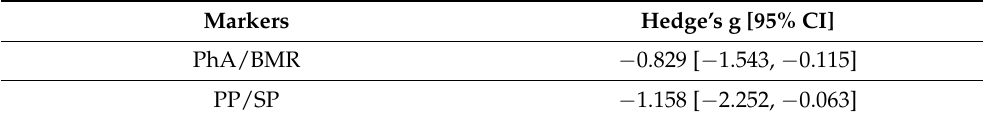
Table 2. Significant correlations in the polycystic ovary syndrome (PCOS) group are presented in Hedge’s g and confidence